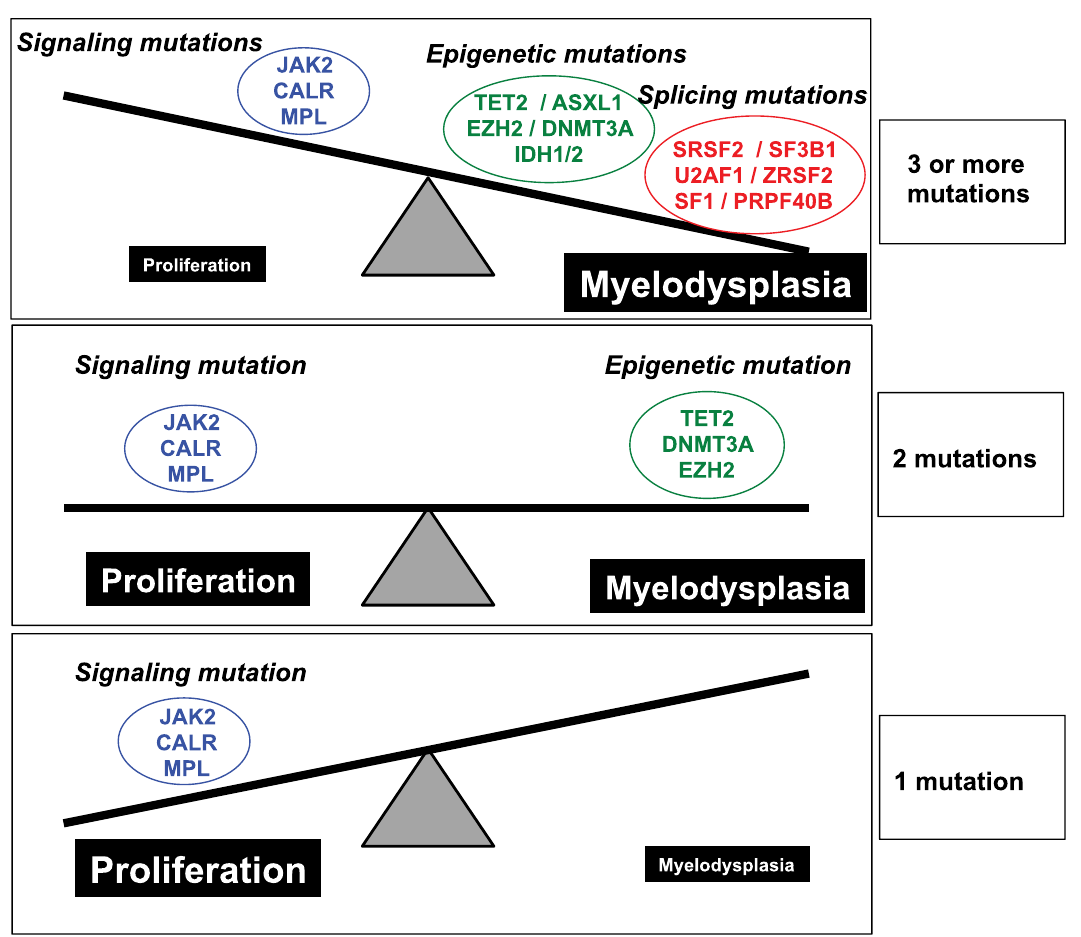
Figure 3. The type and the number of mutations determine the phenotype of the disease. Boundaries between diseases are not easy to determine and could be dependent on the types or the number of mutations. Proliferation is driven mainly by signaling mutations ( JAK2 , CALR , and MPL ) while most of the mutations in epigenetic regulators and spliceosome components lead to differentiation defects. Thus, it can be considered that primary myelofibrosis (PMF) is not a pure myeloproliferative neoplasm (MPN) but a disorder with both myeloproliferative and myelodysplastic components. The heterogeneity of the disease and its prognosis are dependent on the respective levels of each component, and prognosis is poor if myelodysplastic features are